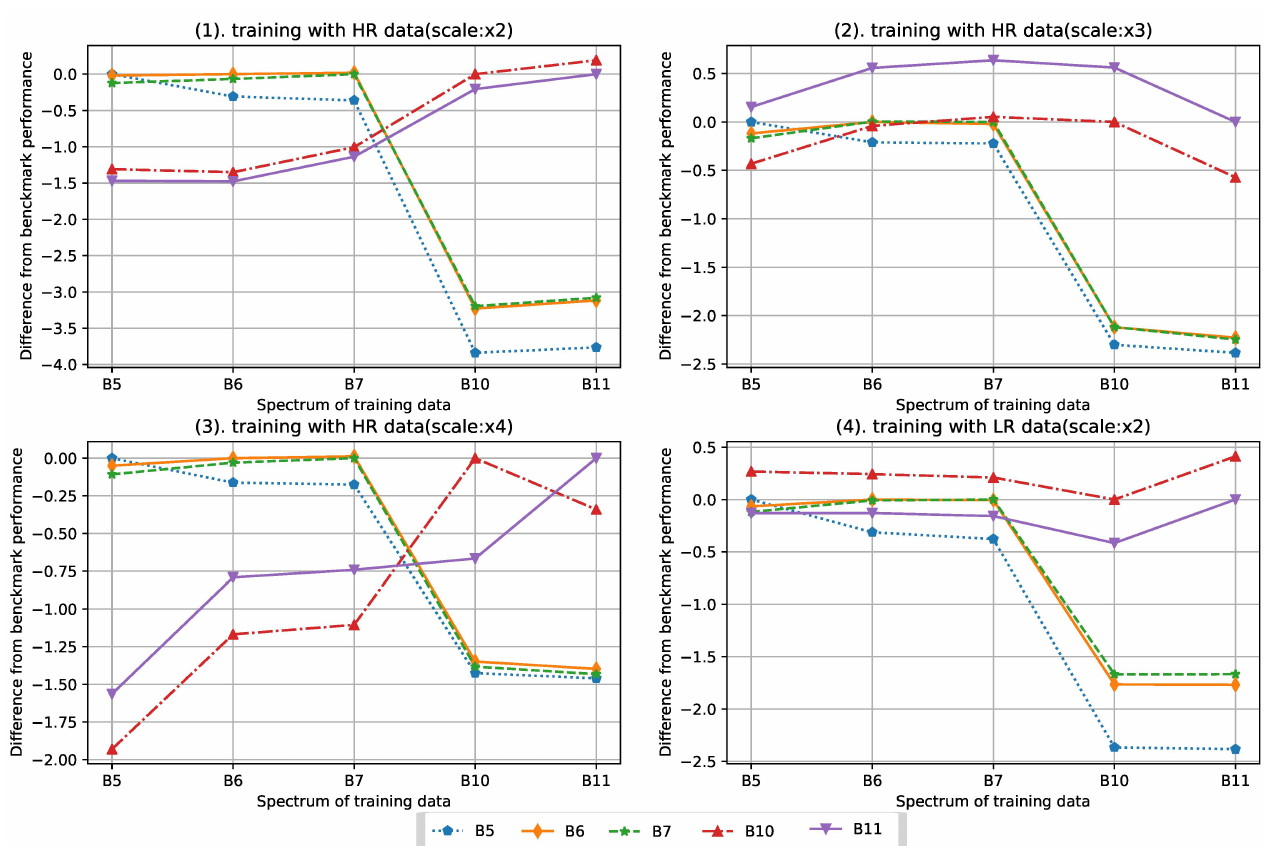
Figure 6. PSNR performance difference between each band and their benchmark result. The bench- mark of each band refers to the result obtained by the model trained with the same band.